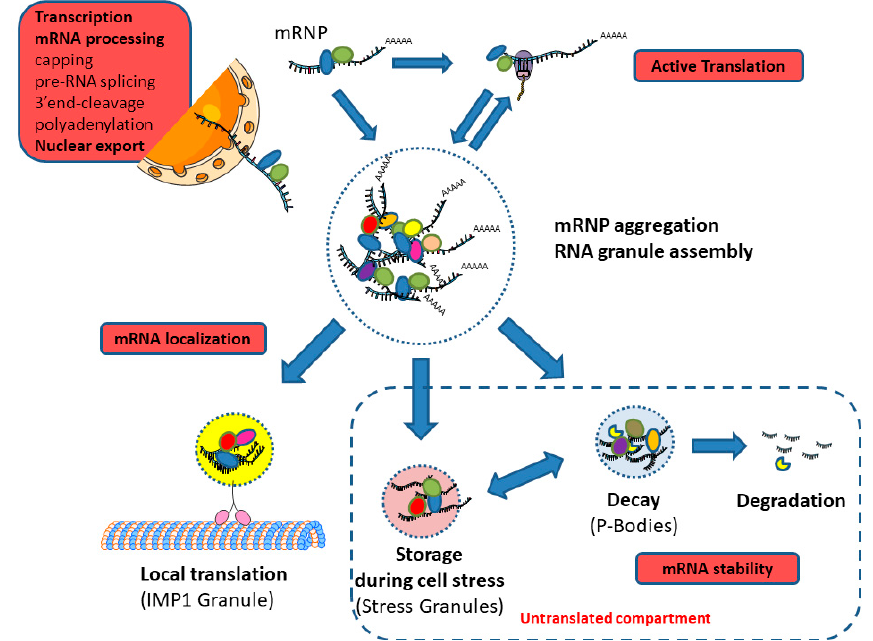
Figure 3. RBP functions and interplay with granule formation. This figure illustrates the different steps where RBPs control mRNA fate in the cell (symbolized by the red rectangles): gene transcription and mRNA processing in the nucleus, nuclear export, and in the cytoplasm formation, remodeling, and biological activities of RNA granules. RNA granules may contain various ribosomal subunits, translation factors, decay enzymes, helicases, scaffold proteins, and RNA-binding proteins which control the localization, stability, and translation of their RNA cargo [35]. Disordered regions of RBPs participate in the dynamic properties of granules by creating protein-protein networks, called hubs. Of the proteins in hubs, 30% are RBPs containing disordered motifs [2]. Several granule categories have been characterized, containing both common and specific granule components according to their functional role. P-bodies (PBs) are involved in mRNA decay. Stress granules (SGs) are involved in mRNA storage during stress. IMP1 (Insulin-like growth factor II mRNA-binding protein 1) granules are thought to be involved in the local translation of specific subsets of mRNAs.